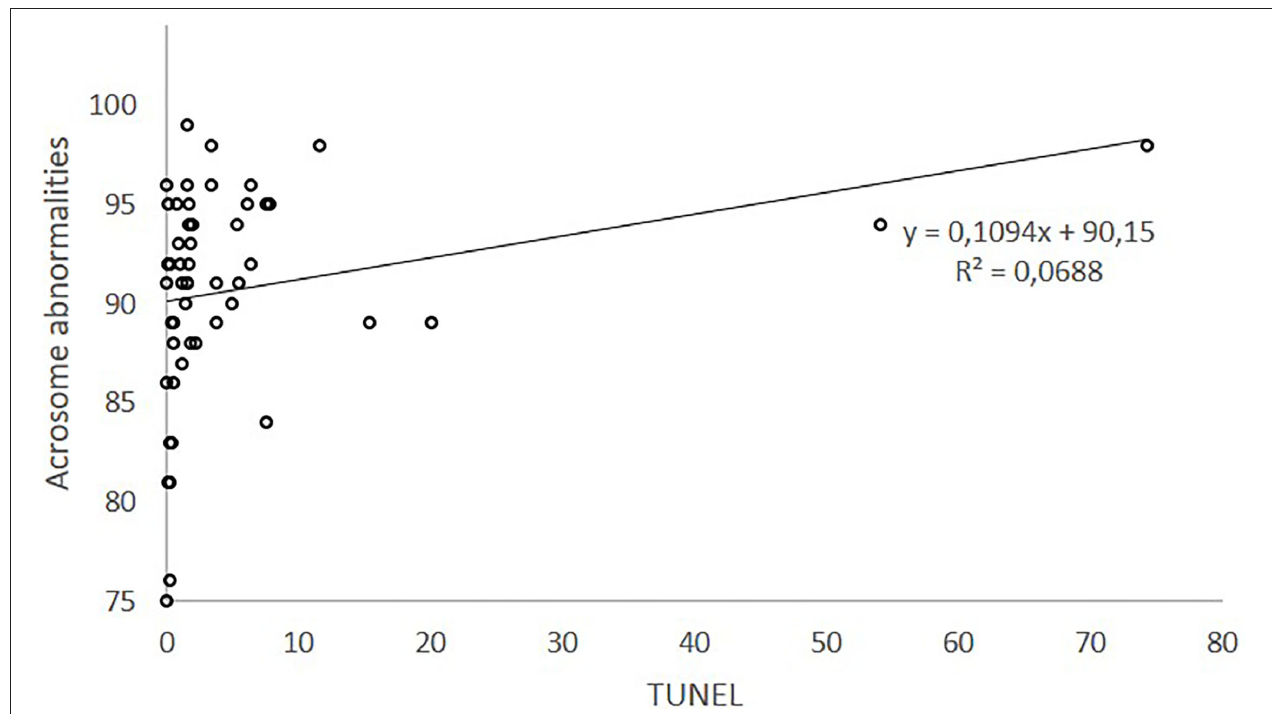
FIGURE 1 | Relationship between acrosome defects and sDF measured by TUNEL.